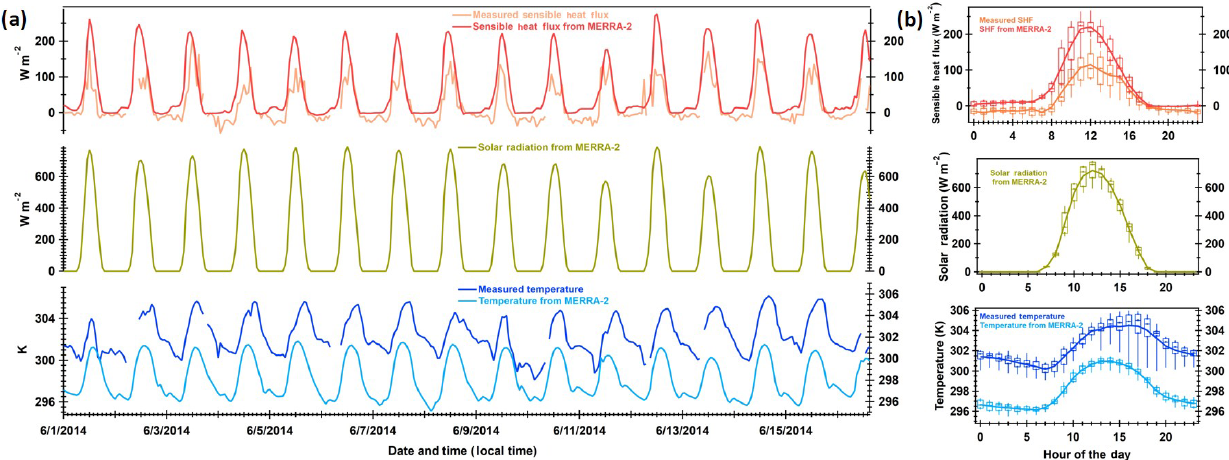
Figure 2. (a) Time series and (b) diel box-and-whisker plots for the measured air temperature and sensible heat flux (SHF) along with estimated air temperature, solar radiation and sensible heat flux obtained from MERRA-2. The time stamp in the x axis of Fig. 2b represents the start time of the respective hourly data bin (e.g. 6 for data averaged between 06:00 and